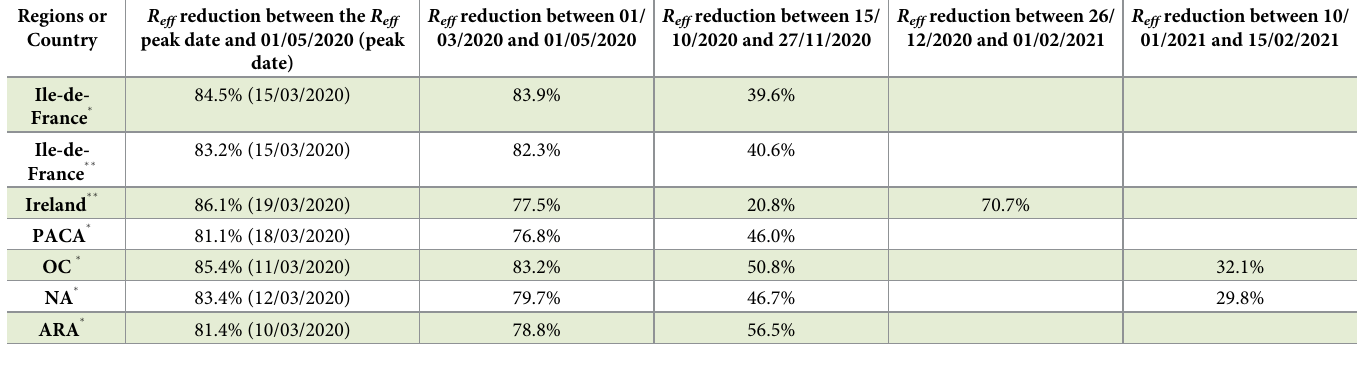
Table 1. Estimated R reduction for Ile-de-France region, Ireland, Provence Alpes Coˆte d’Azur region (PACA), Occitanie region (OC), Nouvelle-Aquitaine region eff (NA), Auvergne Rhoˆne Alpes region (ARA). Regions or